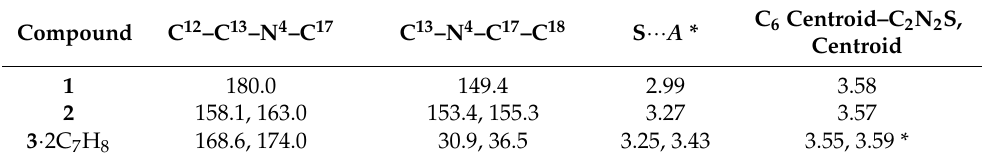
Table 1. Dihedral angles (deg.) and shortened intermolecular contacts (Å) for the 4-bromo-7-(3- pyridylamino)-2,1,3-benzothiadiazole ( Py-btd ) unit in compounds 1 [19] , 2 and 3 · 2C 7 H 8 . For atom numbering, see Scheme 1.